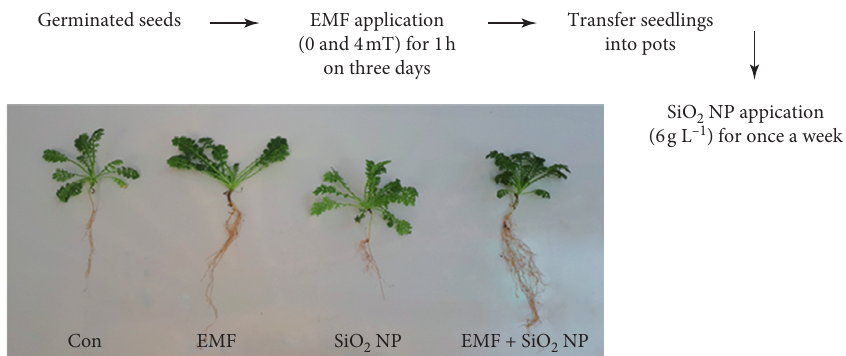
Figure 1: Depiction of EMF and SiO